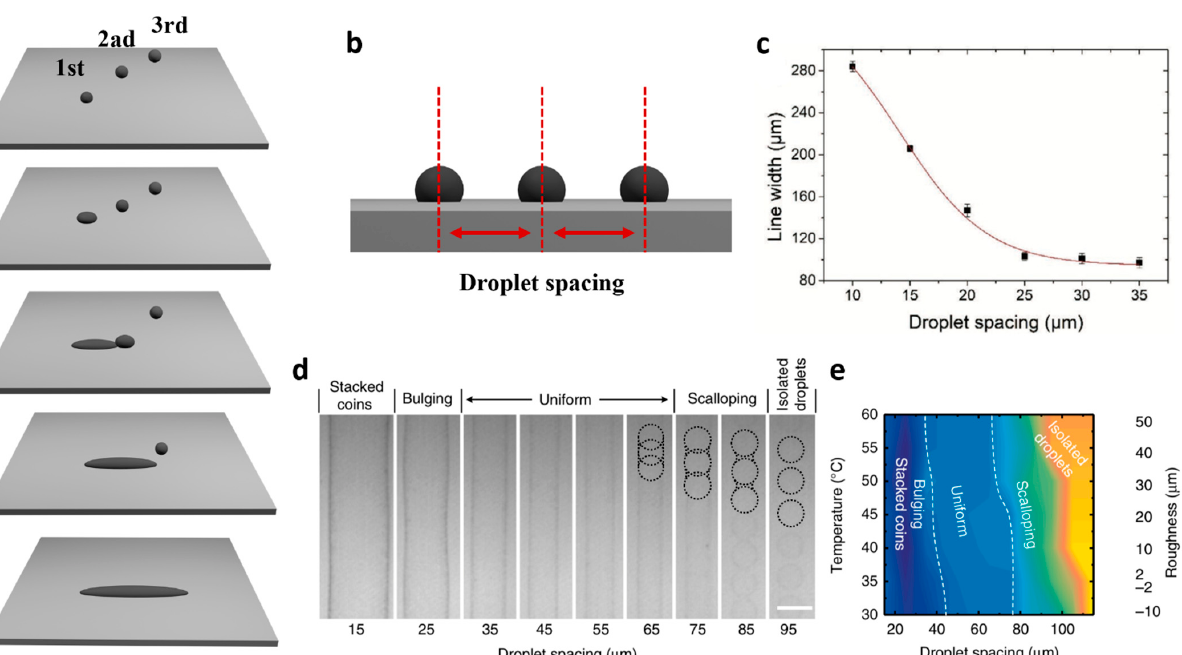
Figure 8. ( a ) Schematic of 2D material patterning process and ( b ) droplet spacing. Characterizations of the printed BP films upon printing repetition (N): ( c ) printing line width variation with respect to droplet spacing. Reprinted with permission from Ref. [22] . Copyright 2021 John Wiley and Sons. ( d ) Optimization of BP printing conditions. a BP printed on Si/SiO 2 at 60 °C showing the effect of droplet spacing on line morphology, photos taken by printer fiducial camera, scale bar, 100 μ m; ( e ) effect of droplet spacing and printing temperature on the roughness along line edges, the roughness from uniform to stacked coins is defined as negative. Reprinted with permission from Ref. [20] . Copyright 2017 Springer Nature.